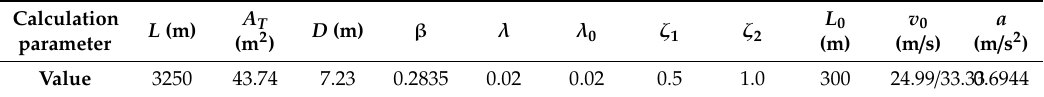
Table 3. Parameters for theoretical calculation for piston